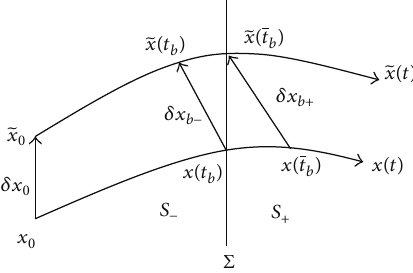
Figure 5: The original and disturbed orbits.